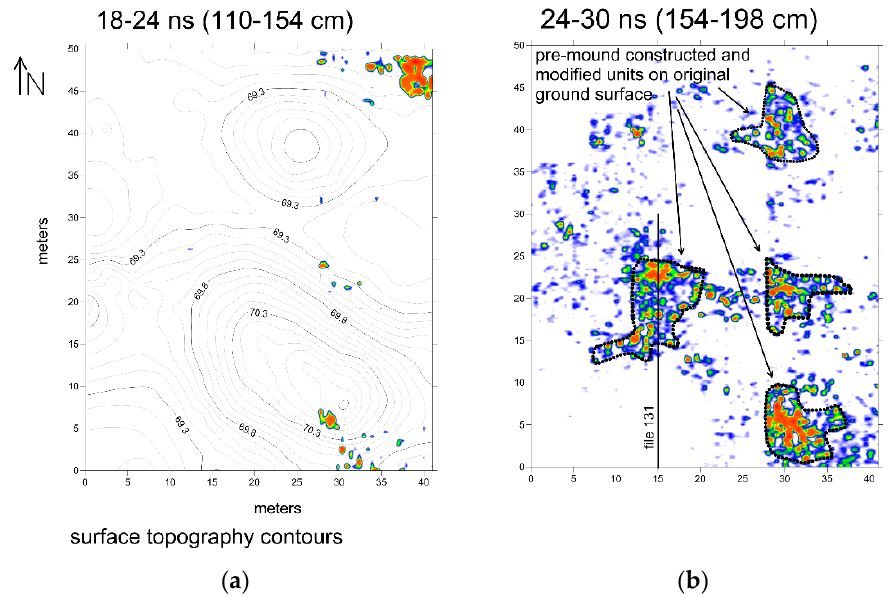
Figure 7. Amplitude slice maps of the two deepest slices at Shadforth’s Mounds showing the concentrations of high amplitude reflections on the pre-mound surface in the deepest slice from a 154–198 cm depth. The surface topographic contours are superimposed on the 110–154 cm depth slice. ( a ) Topographic Contour map; ( b ) High amplitude concentrations on the pre-mound ground surface.